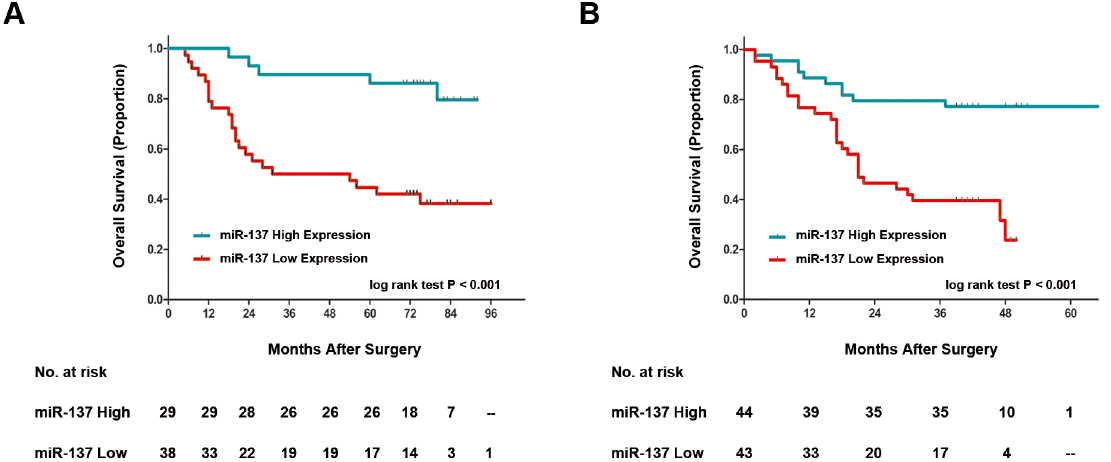
Fig 2. Analyses of overall survival according to the expression of miR-137 in gastric cancer patients. Kaplan-Meier analyses of overall survival according to miR-137 expression in (A) Training set (n = 67) and (B) Validation set (n = 87). P value was calculated by log-rank